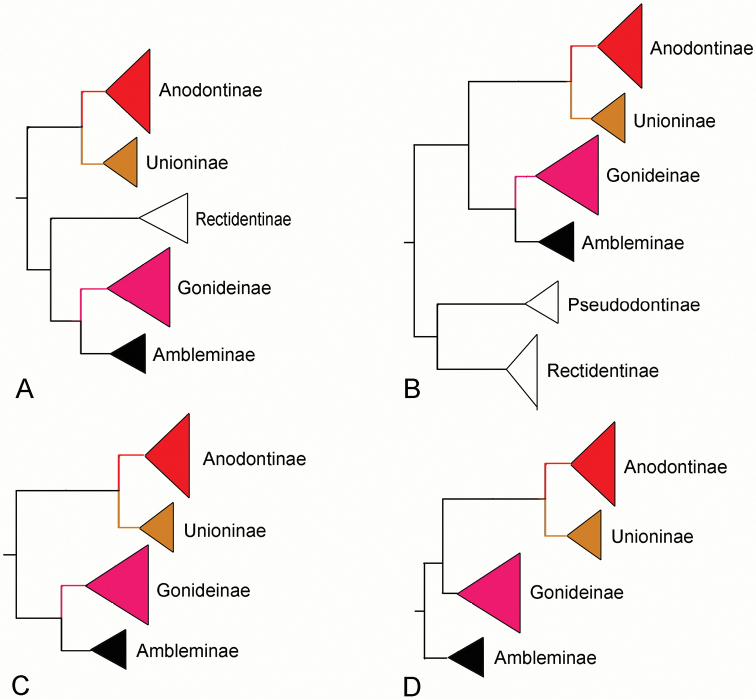
Hypotheses of phylogenetic relationships among subfamilies of the Unionidae form this and other studies. ALopes-Lima et al. (2017a)BBolotov et al. (2017a)CHuang et al. 2013; Burzyński et al. 2017; Huang et al. 2018; Wu et al. 2016, 2017bD This study.